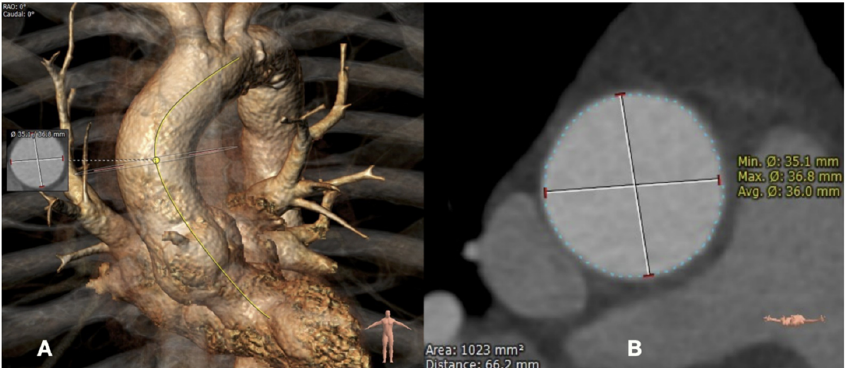
Figure 3. Screenshot of the “3mensio Vascular” program: ( A ) a 3D reconstruction of the ascending aorta. Solid yellow line is the centerline; ( B ) axial presentation of the mid-ascending plane of the ascending aorta with automatically measured size values.